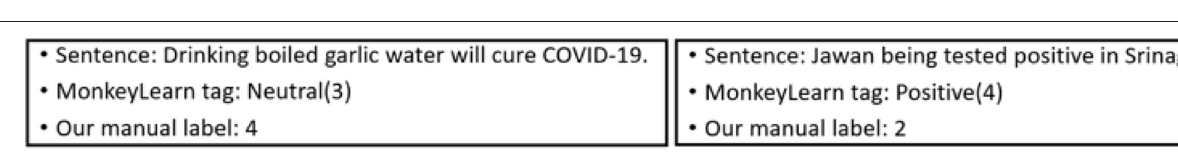
FIGURE 4 | Veracity (A) and sentiment (B) statistics of our collected dataset.